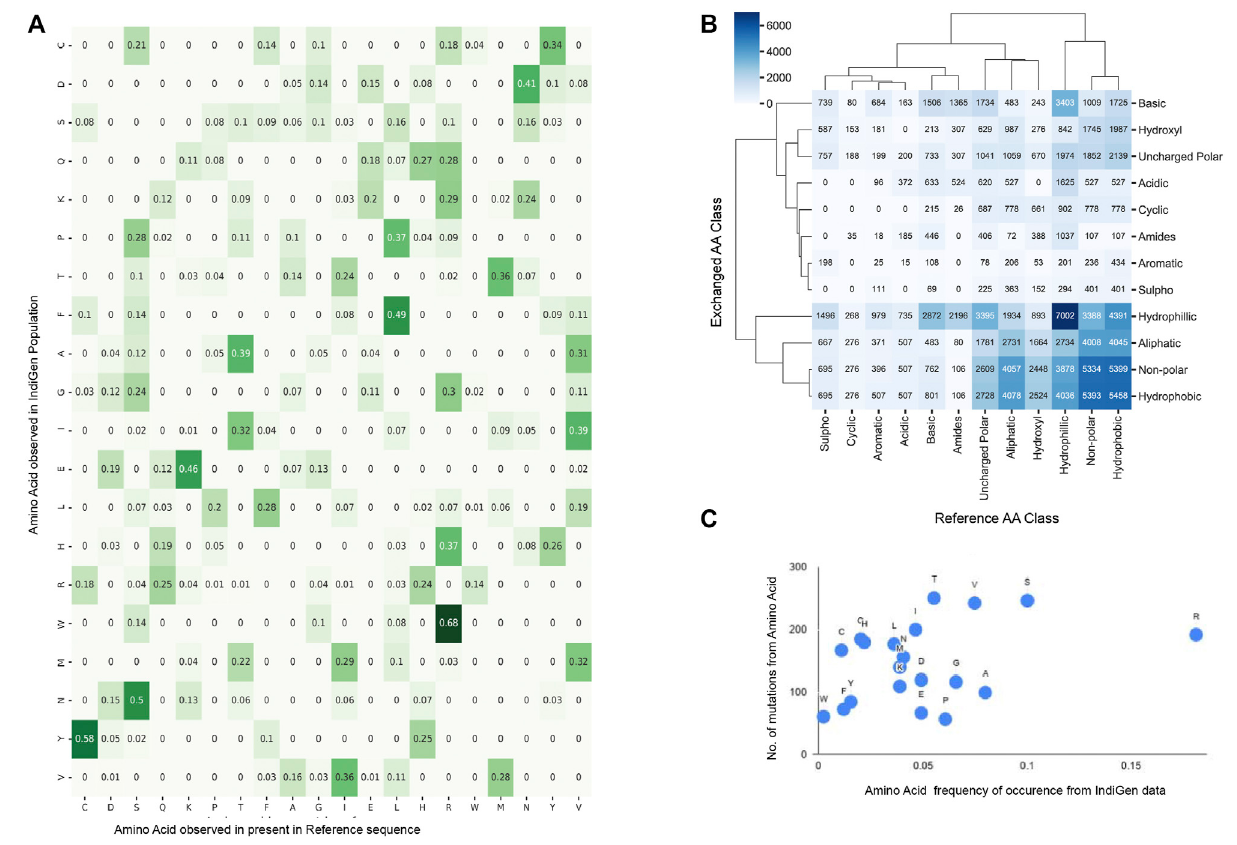
Frontiers in Pharmacology |